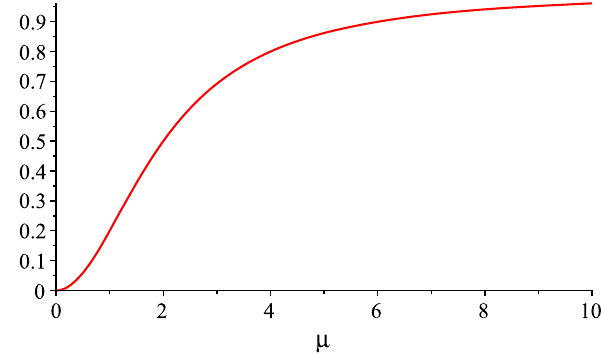
Fig. 2 The dimensionless numerical factor μ 2 /( 4 + μ 2 ) (vertical axis) as a function of μ (horizontal axis)